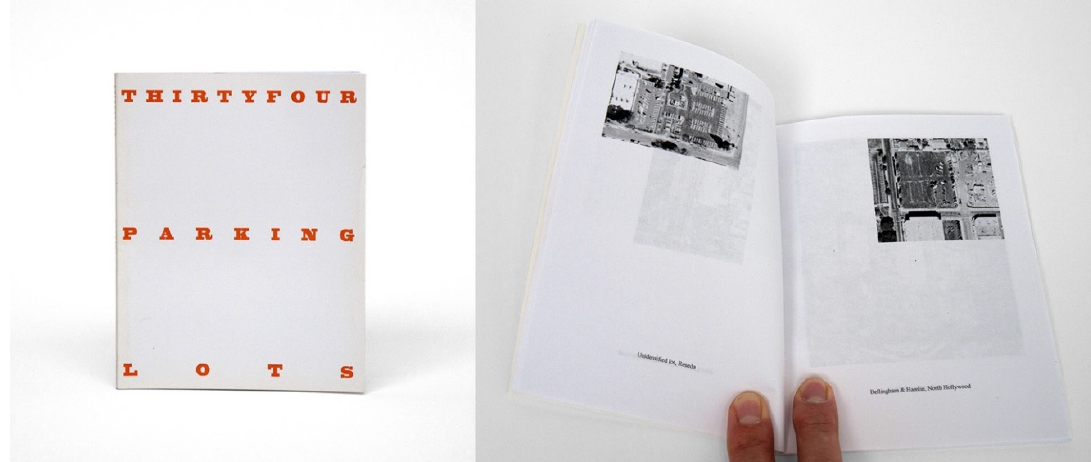
Figure 20. Susan Porteous, Thirtyfour Parking Lots Forty Years Later , 2007.